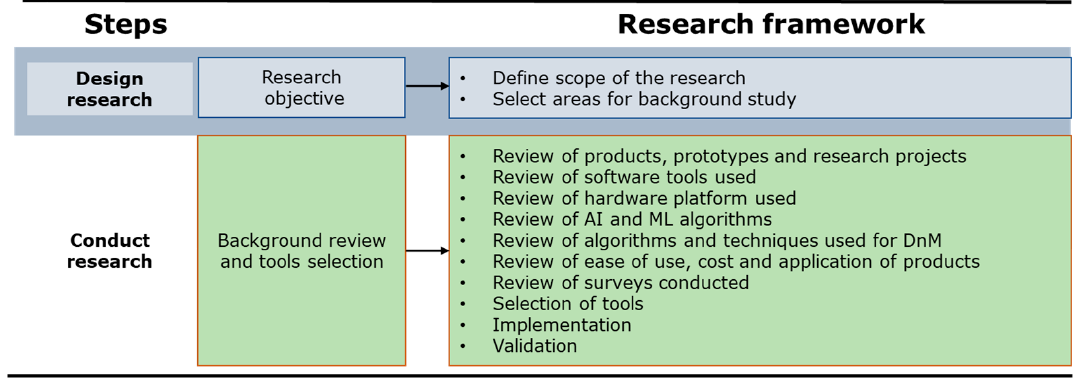
Figure 2. Research Methodology.